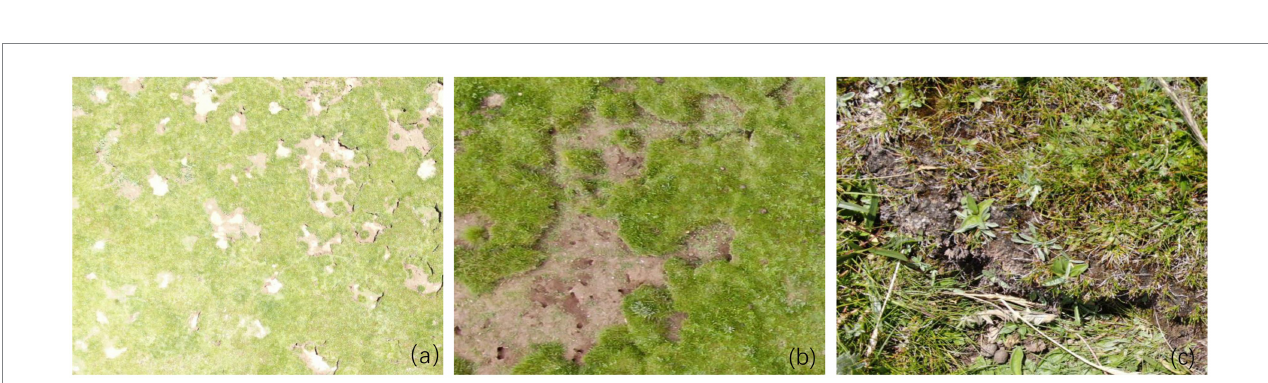
FIGURE 4 Aerial photographs of Kobresia pygmaea community, (A) the patch characteristics of Kobresia pygmaea community observed at height of 20 m, (B) the phenomenon of cracking and collapse in Kobresia pygmaea community observed at height of 2 m, and (C) the felty root mat of Kobresia pygmaea community observed at height of 2 m with double wide-angle zoom